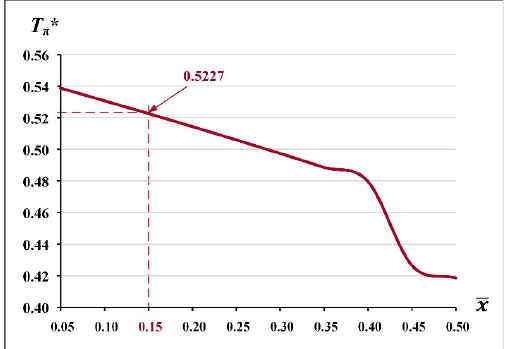
Fig. 9. T π *’s behavior relating to the mean scrap rate